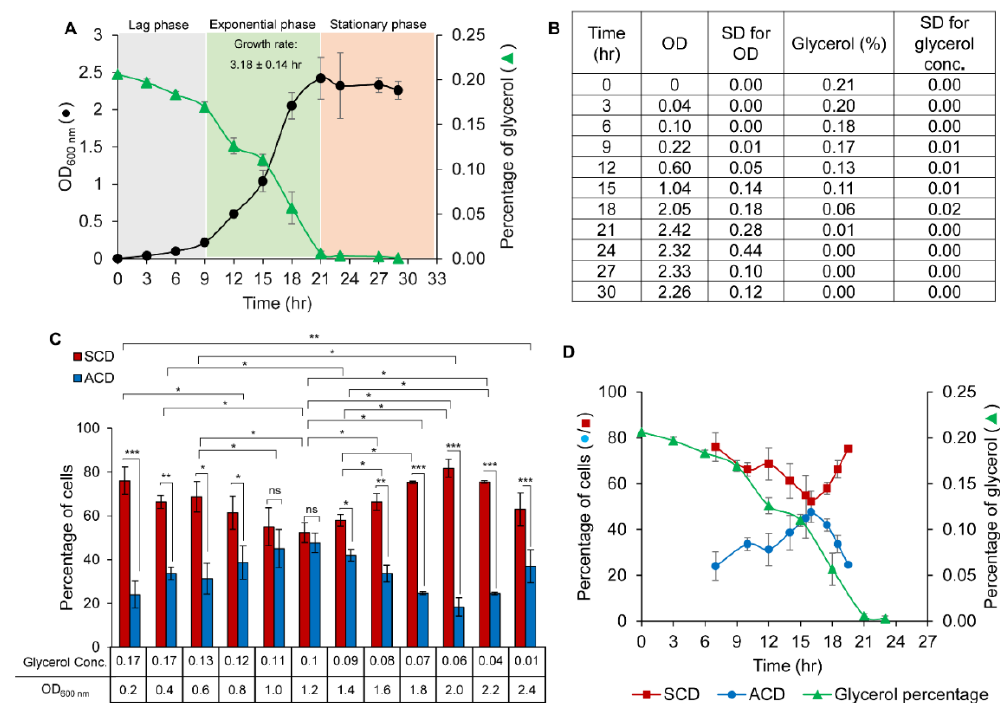
Figure 1. Growth curve of Msm cells and glycerol concentration in the medium. Percentage of the Msm cells undergoing ACD and SCD at different OD values and glycerol concentration. ( A ) ( ● ) Growth curve of Msm cells grown in Middlebrook 7H9 liquid medium containing 0.2% glycerol and 0.05% Tween 80 and ( ▲ ) Glycerol concentration (percentage) in the culture medium with respect to OD and time; n = 3. ( B ) The levels of glycerol (with ± SD) at 3 h interval time points with the respective OD values of Msm growth from which the graph ( A ) was constructed ( n = 3). ( C ) Bar graph represents the percentage of cells dividing by ACD (blue bar) and SCD (red bar) at different glycerol concentrations and OD values of cells grown in Middlebrook 7H9 liquid medium containing 0.2% glycerol and 0.05% Tween 80 ( n = 300). ( D ) Comparison of the percentage of the cells undergoing ( ● ) ACD and ( ■ ) SCD with respect to growth progression (in terms of time) dependent reduction in ( ▲ ) glycerol levels in the medium. The data shown are mean values ± s.d. of the biological triplicates. * p < 0.05, ** p < 0.01, *** p < 0.001, ns—no significance via two-tailed t -test.